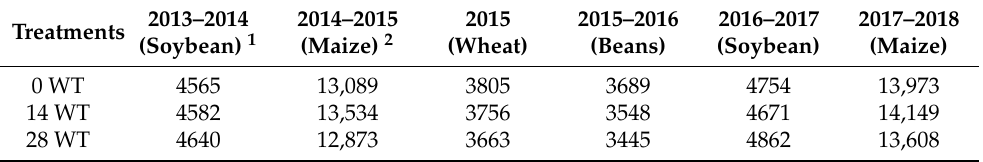
Table 1. Crop yields (kg ha − 1 ) in the experimental area before soil mechanical interventions.